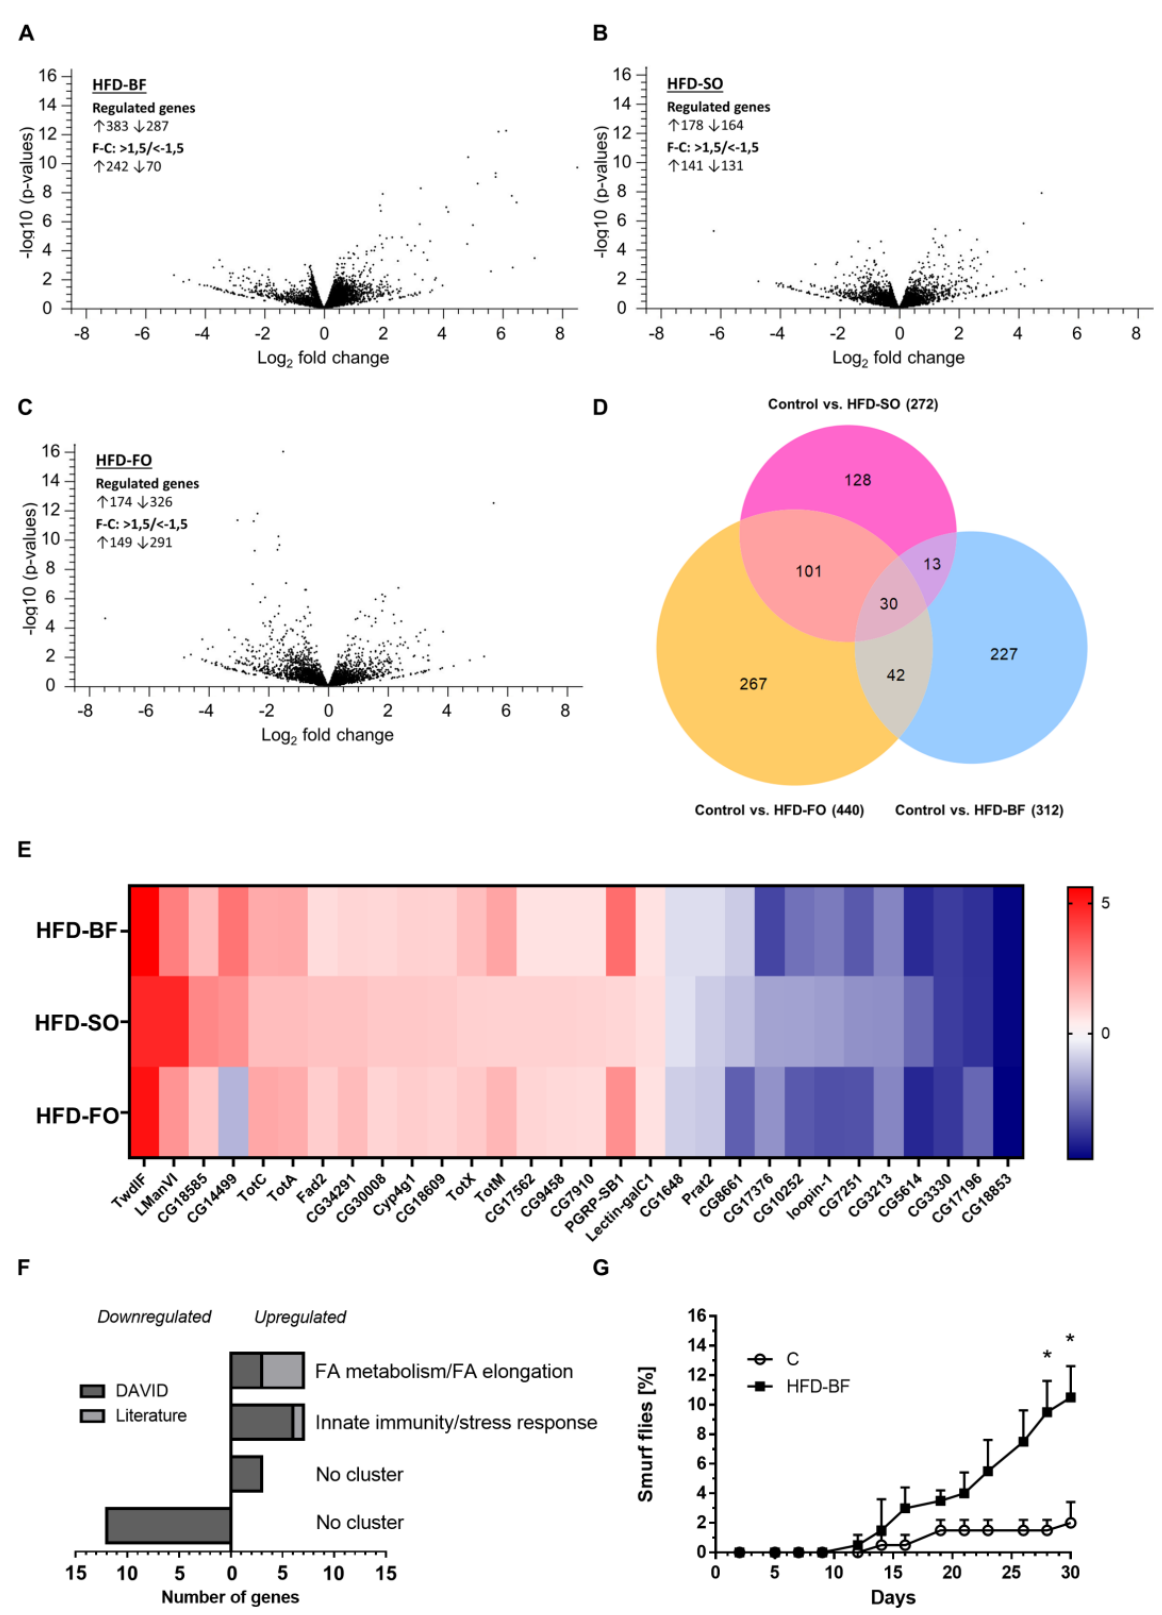
Figure 11. Transcriptional alterations in female D. melanogaster following short-term intake of a high-fat diet with either 12% ( w / v ) butterfat (HFD-BF), sunflower oil (HFD-SO) or fish oil (HFD-FO). Female D. melanogaster w 1118 were fed ad libitum with SY control diet or experimental HFDs additionally supplemented with 12% ( w / v ) butterfat (HFD-BF), sunflower oil (HFD-SO) or fish oil (HFD-FO). Flies were maintained under standard conditions for 3 days, before they were harvested for RNA isolation from whole-body lysates. RNAs were sequenced by a HiSeq3000/HiSeq 4000 sys- tem. ( A – C ) The volcano plots represent the log 2 fold change in gene expression plotted against the log 10 ( p -value) for the different HFD groups in comparison to the control group. The numbers of significantly regulated genes without and with considering a minimum fold change threshold of > 1.5/< − 1.5 are depicted. ( A ) More genes were significantly upregulated than downregulated by the ingestion of an HFD-BF. ( B ) The transcription of a similar number of genes was significantly up- and downregulated following the dietary intake of an HFD-SO. ( C ) The ingestion of an HFD-FO